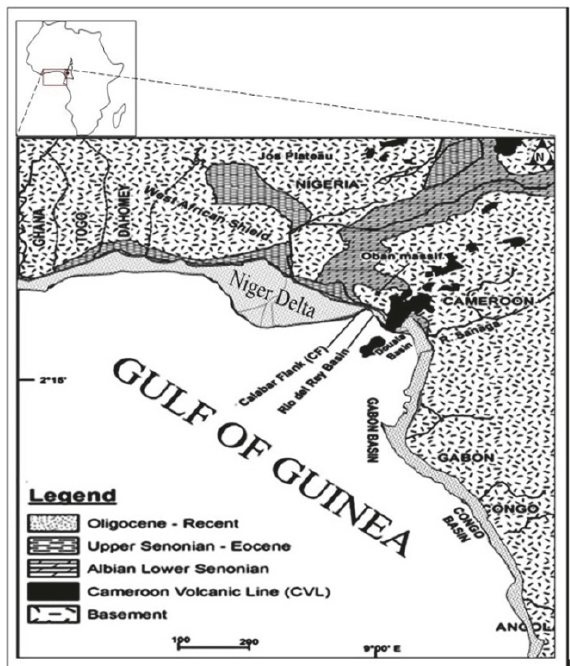
Figure 1: A regional map of the Gulf of Guinea showing the spatial relationship between the Rio del Rey and other coastal sedimentary basins within the